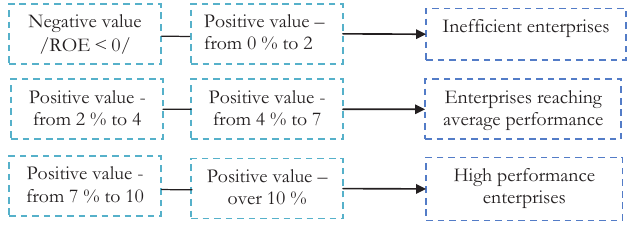
Fig. 2 - The enterprise differentiation into the performance groups. Source: